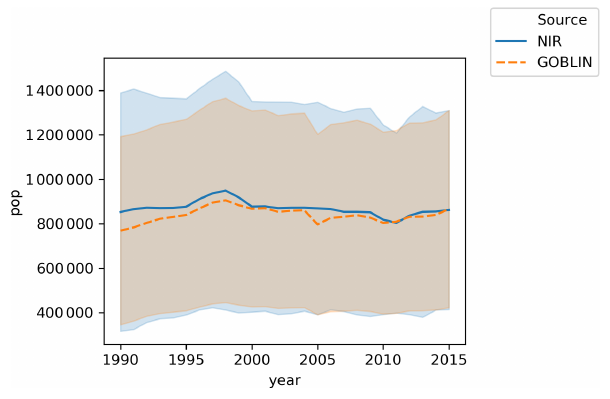
Figure 6. Average cattle livestock population (lines) and standard deviation among sub-groups over time (shaded areas) input into the national inventory report (NIR) and generated by the GOBLIN herd module from milking and suckler cow